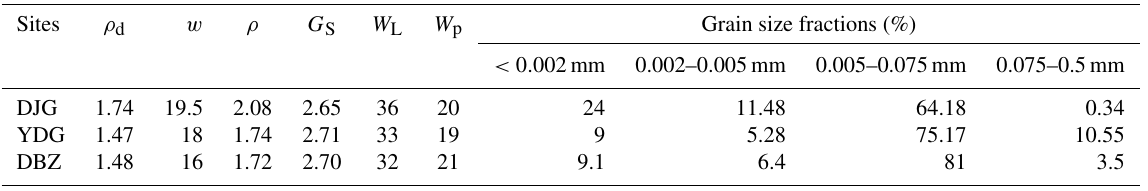
Table 1. Physical parameters of slip zone loess. Sites